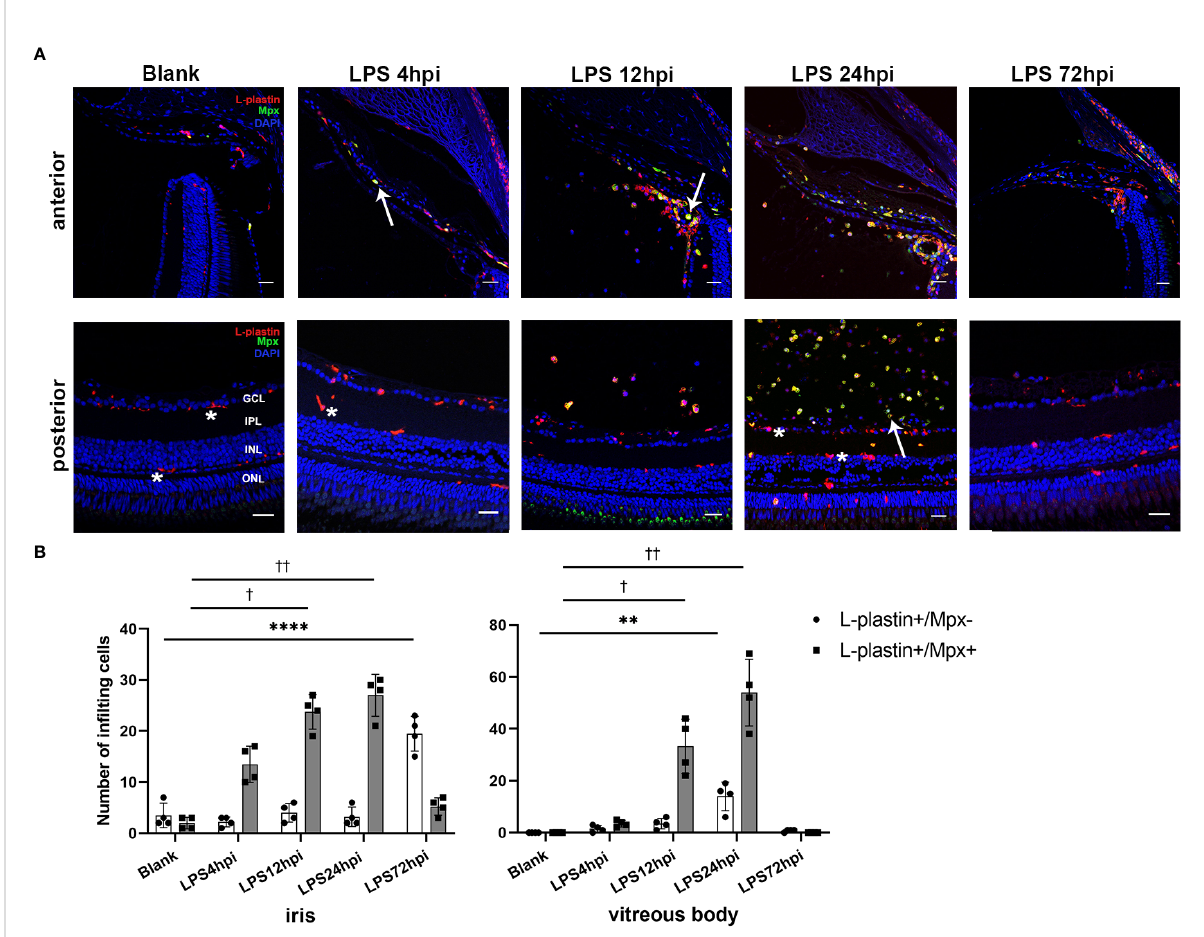
FIGURE 2 Distribution of immune cells during EIU in fl ammation process in zebra fi sh. (A) L-plastin (magenta), Mpx (green), and DAPI (blue) staining was seen in cryosections at 0 hpi (blank control), 4 hpi, 12 hpi, 24 hpi and 72 hpi of LPS. ONL, outer nuclear layer, INL, inner nuclear layer, IPL, inner plexiform layer, GCL, ganglion cell layer. Asterisk: L-plastin+/Mpx- cell. White arrow: L-plastin+/Mpx+ cell. Scale bar: 20 m m. (B) Quanti fi cation of immune cells in the iris and vitreous body at each time point (mean ± SD; * P < 0.05, ** P < 0.01, **** P < 0.0001, the number of L-plastin +/Mpx- cells were compared; † P < 0.05, †† P < 0.01, number of L-plastin+/Mpx+ cells were compared, one-way